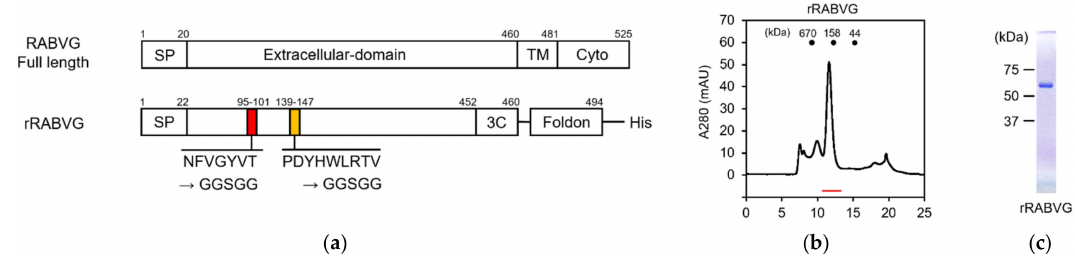
Figure 3. Construction and purification of rabies virus glycoprotein. ( a ) Schematic structures of the RABVG full length and the rRABGV. SP, signal peptide; TM, transmembrane domain; Cyto, cytoplasmic tail; 3C, HRV-3C protease cleavage site; Foldon, T4 fibritin trimerization domain. ( b ) The size exclusion chromatogram of rRABVG. The red line represents the elution position of rRABVG. ( c ) SDS-PAGE of purified rRABVG under reducing conditions.